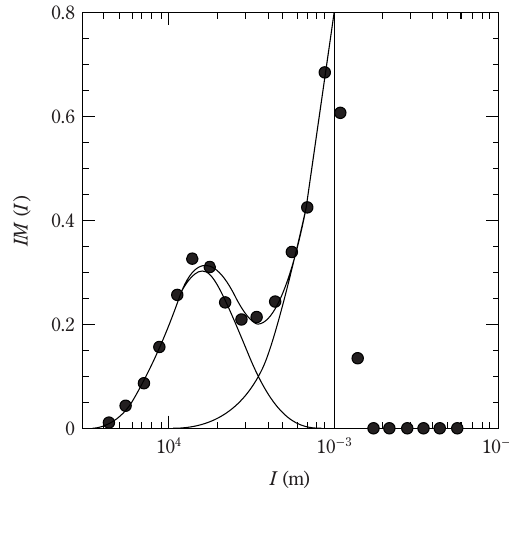
Fig. 8 Normalised tracer distribution 1 min after adding tracer in the size range 1-1.18 mm [39]. Used for deduction of breakage function